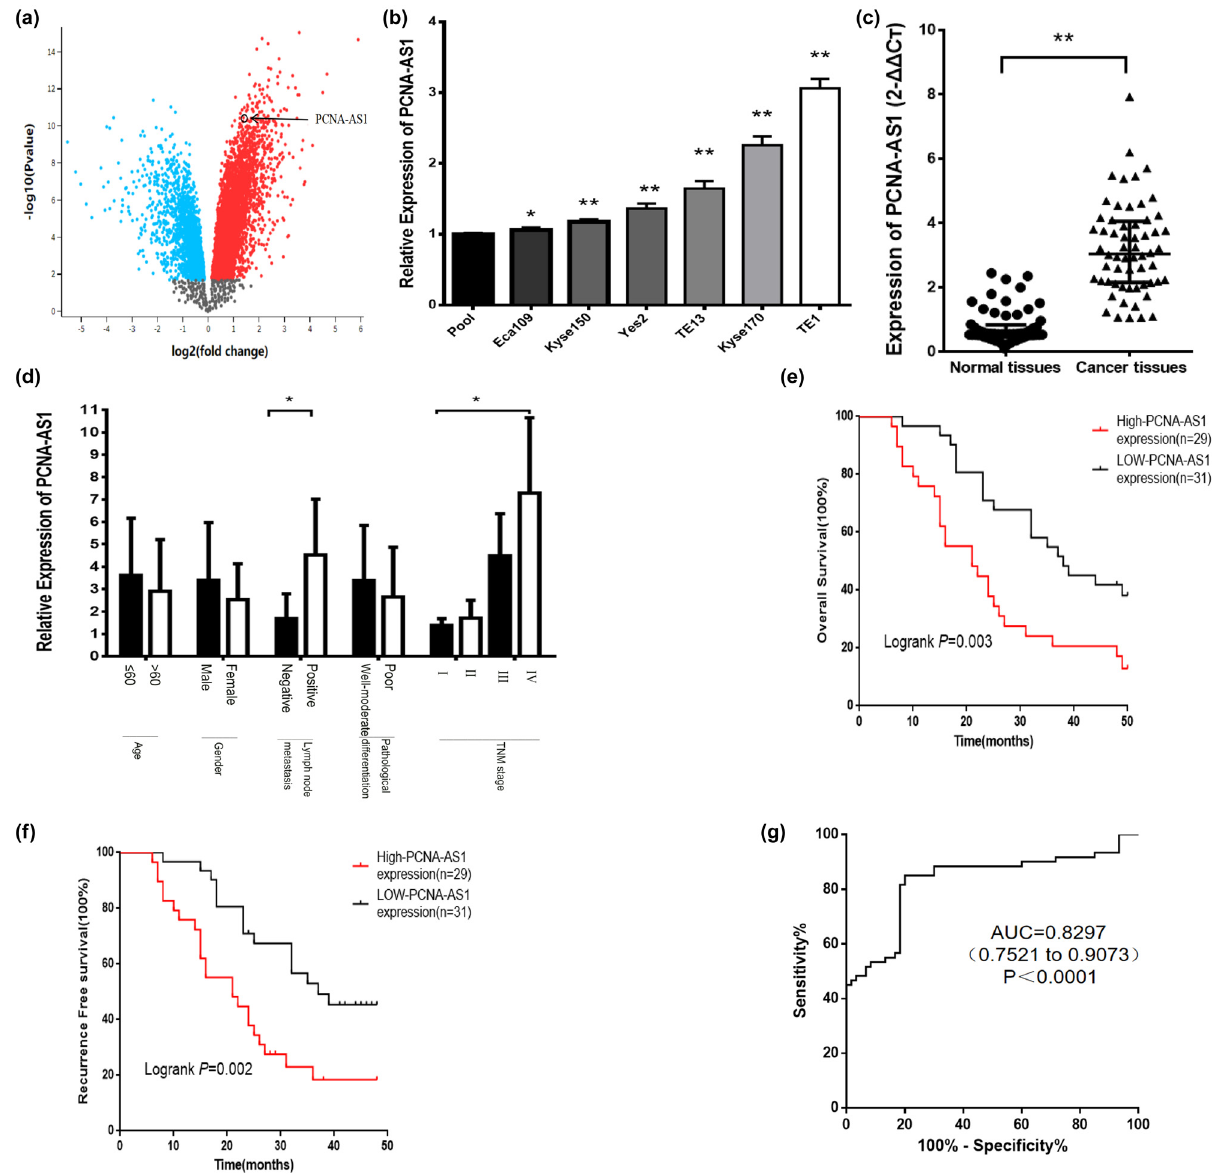
Figure 1: PCNA - AS1 is signi fi cantly upregulated and associated with clinicopathological characteristics. ( a ) PCNA - AS1 is highly expressed in GSE75241 ( log | fold change | > 1, P < 0.05 ) . ( b ) The expression of PCNA - AS1 in a panel of human esophageal cancer cell lines by qRT - PCR. ( c ) The expression of PCNA - AS1 in 60 pairs of ESCC tissues and normal tissues. ( d ) The relationship between PCNA - AS1 expression and clinicopathological characteristics of ESCC patients. ( e and f ) Expression of PCNA - AS1 was negatively associated with the OS and RFS of patients with ESCC. ( g ) ROC curve analysis shows an AUC of 0.8297 to distinguish ESCC from adjacent normal tissues. *P < 0.05 and **P <